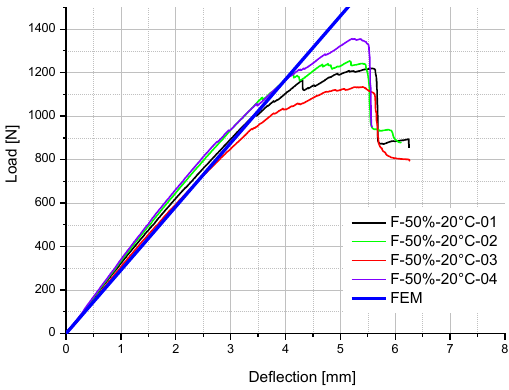
Figure 12. Comparison of experimental and FE results on the load-deflection curve of F-50%-20 °C specimens.